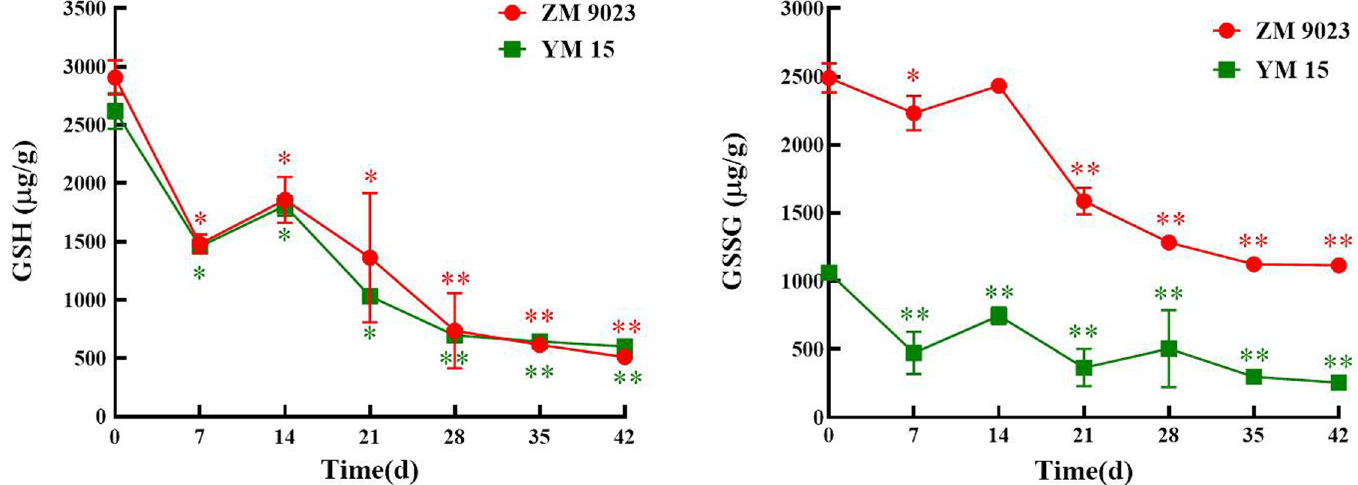
Fig 5. Changes in the glutathione contents of the wheat cultivars ZM 9023 and YM 15 during artificial aging. At least three independent experiments were performed; data are shown as mean ± SD. � p < 0.05; �� p < 0.005. rate and germination potential) were significantly and negatively correlated with the ROS and carbonyl protein contents. In addition, the carbonyl protein content was significantly and pos- itively correlated with the ROS content. The results indicated correlations between seed vigor and carbonyl protein content.